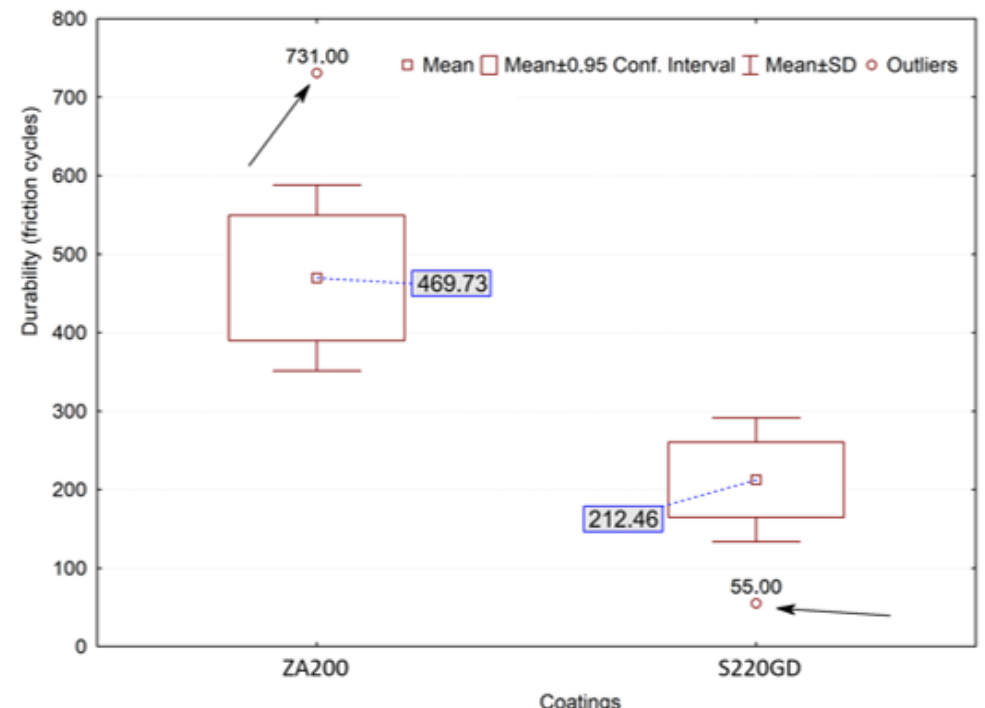
Figure 10. Frame graph of the results for the abrasibility of the sheet roofing